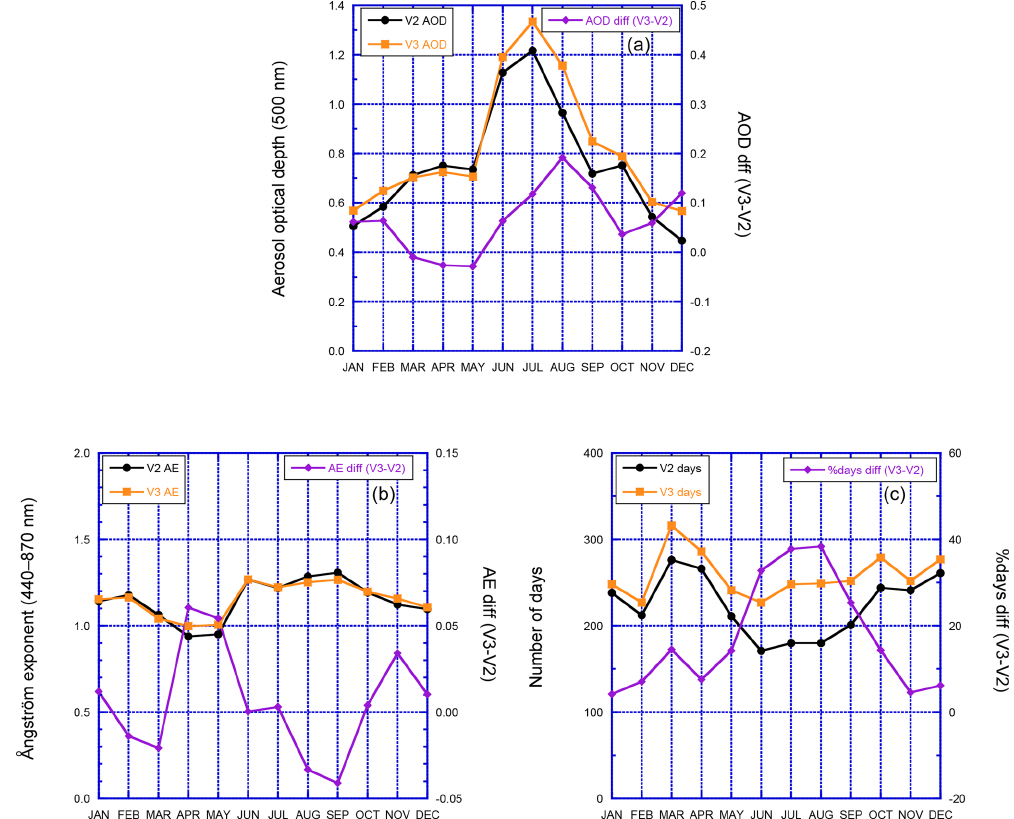
Figure 25. Similar to Fig. 23 except for Xianghe, China (lat 39.75, long 116.96), from 2001 to 2017, except 2009.